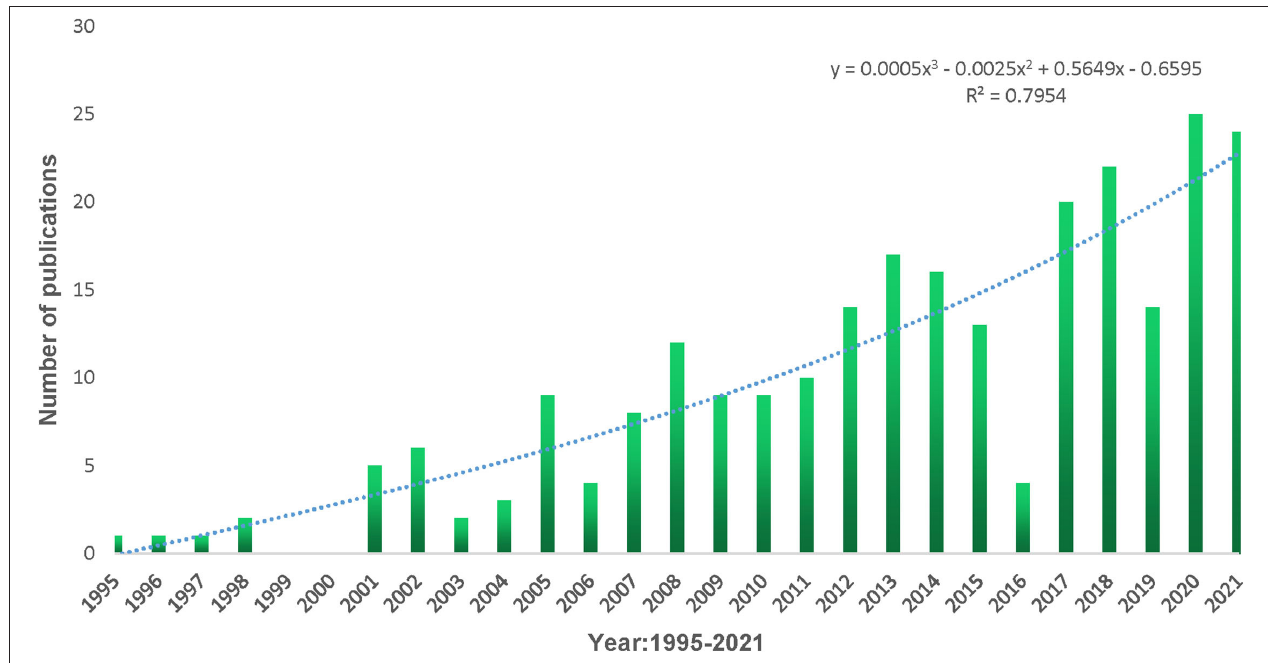
FIGURE 2 | Annual output of publications and growth